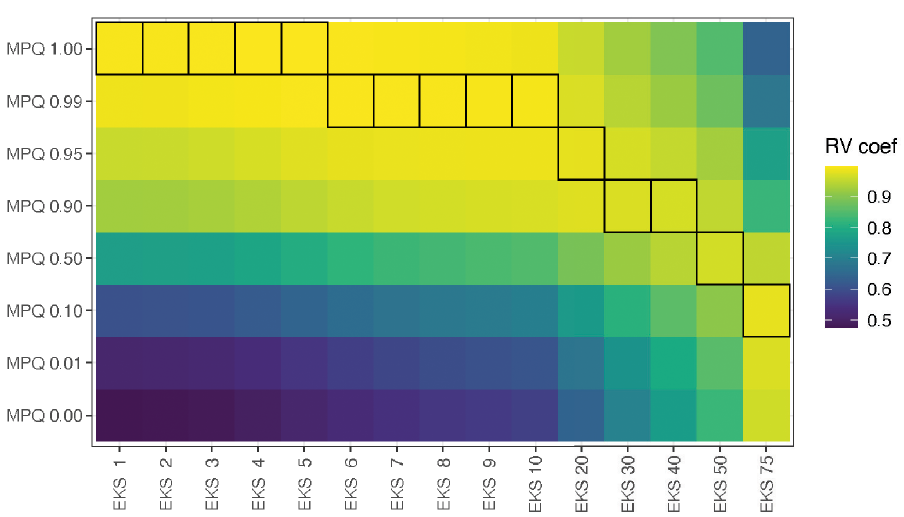
Fig 8. EKS distance matrices between the samples in the colon cleanout dataset are similar to the MPQ distance matrices. Each cell represents the RV coefficient between a pair of distance matrices, with yellow cells corresponding to large RV coefficients and purple corresponding to smaller RV coefficients. Outlined boxes indicate the maximum RV coefficient within a column.